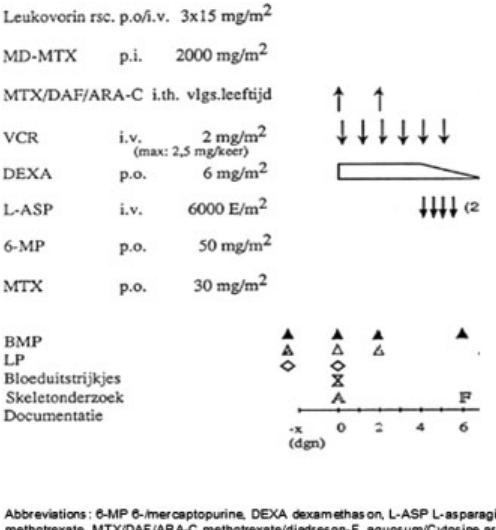
Fig. 1 DCOG ALL-9 induction protocol. ALL, acute lymphoblastic leukemia; DCOG, Dutch Childhood Oncology Group.